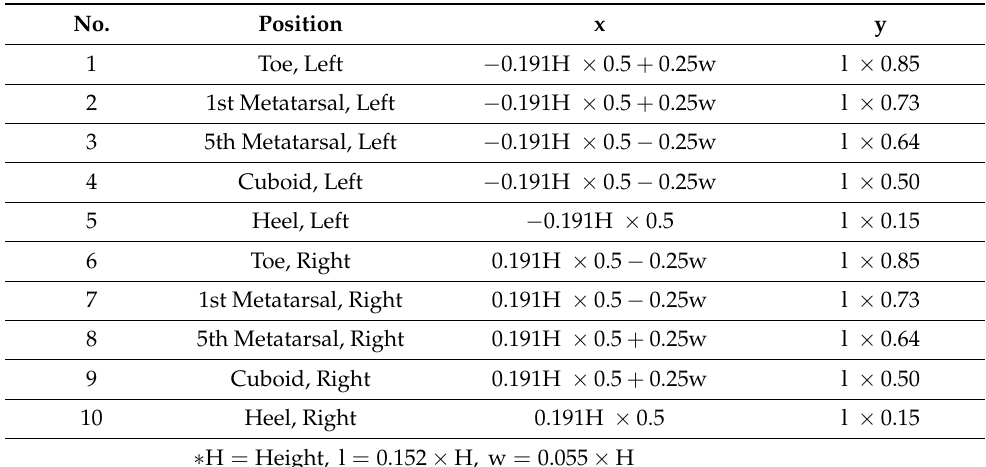
Figure A1. Gait analysis system: ( a ) insole device, ( b ) schematic of the data acquisition system (DAS), ( c ) location of force sensing resistors (FSRs) ( d ) developed system. Table A1. Location of FSRs for insole